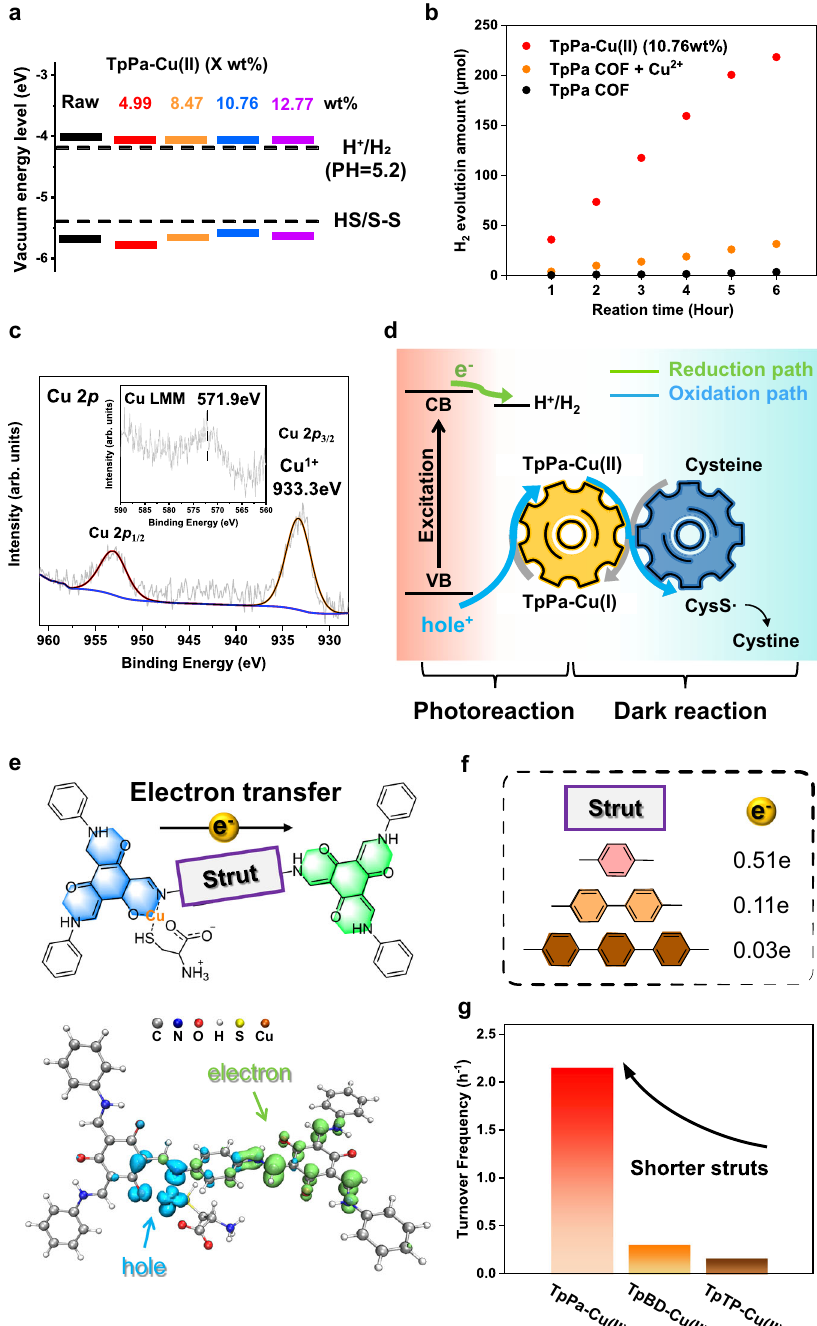
Fig. 2 | Energy-band structures, photocatalytic H2 evolution, XPS spectra, proposedmechanism,andexcited-statesimulation.a Energy-bandstructuresof TpPa-COFand TpPa-Cu(II)-COFscontaining 4.99, 8.47, 10.76, and 12.77wt% of Cu 2+ ions, respectively. b Time courses for photocatalytic H 2 evolution under visible irradiation for TpPa-COF, TpPa-Cu(II)-COF(10.76wt%), and a mixture of TpPa-COF andCu(OAc) 2 . c Cu2 p XPSandCuLMMauger(inset)spectraoftherecycledTpPa- Cu(II)-COF after 1-h photocatalysis. d Illustration of photocatalytic mechanism